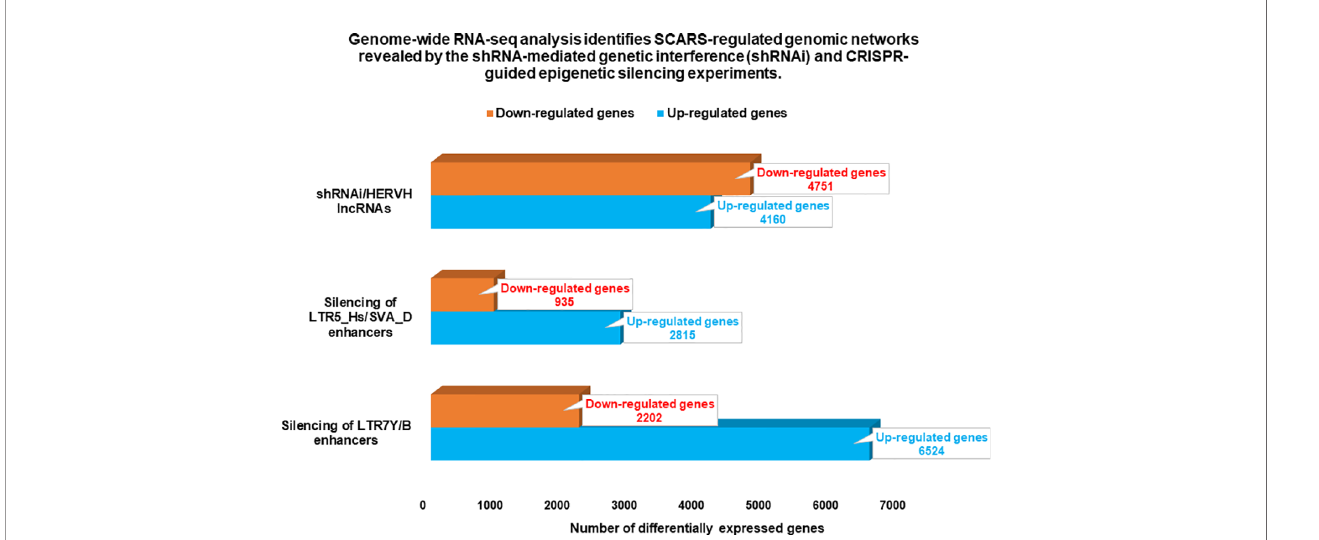
FIGURE 3 | Genome-wide gene expression pro fi ling experiments identify thousands of SCARS-regulated genes in hESC. Genome-wide RNAseq analyses were performed on genetically engineered hESC to identify genes regulated by SCARS-encoded regulatory signals derived from HERV-H, LTR5_Hs/SVA_D, and LTR7Y/B loci. Genes regulated by HERV-H ncRNA molecules were identi fi ed using shRNA-mediated genetic interference (100), while genes regulated by LTR5_Hs/SVA_D and LTR7Y/B enhancers were identi fi ed employing CRISPR/Cas-guided epigenetic silencing (22).